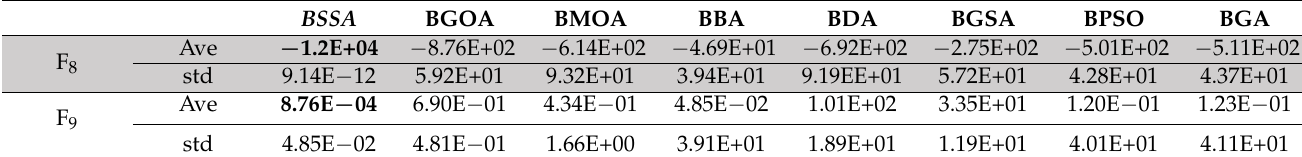
Table 6. Results for the BSSA and other algorithms in multimodal test